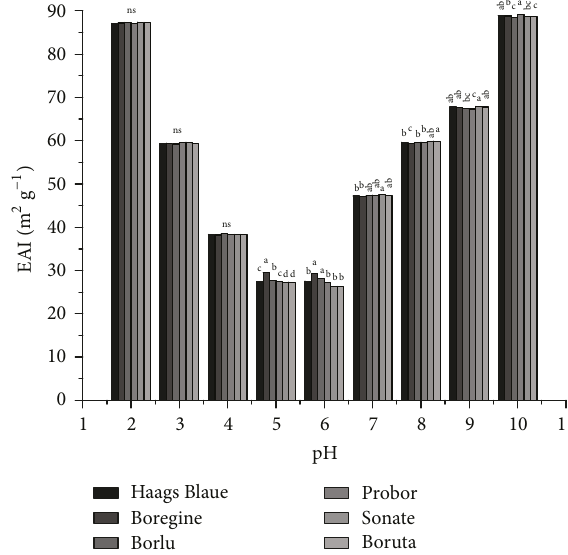
Figure 2: Effect of pH on the emulsion activity index (EAI) of six varieties of Lupinus angustifolius protein isolates. Different letters indicate significant differences among varieties at 𝑃 < 0.05 ; ns indicates nonsignificance ( 𝑃 > 0.05